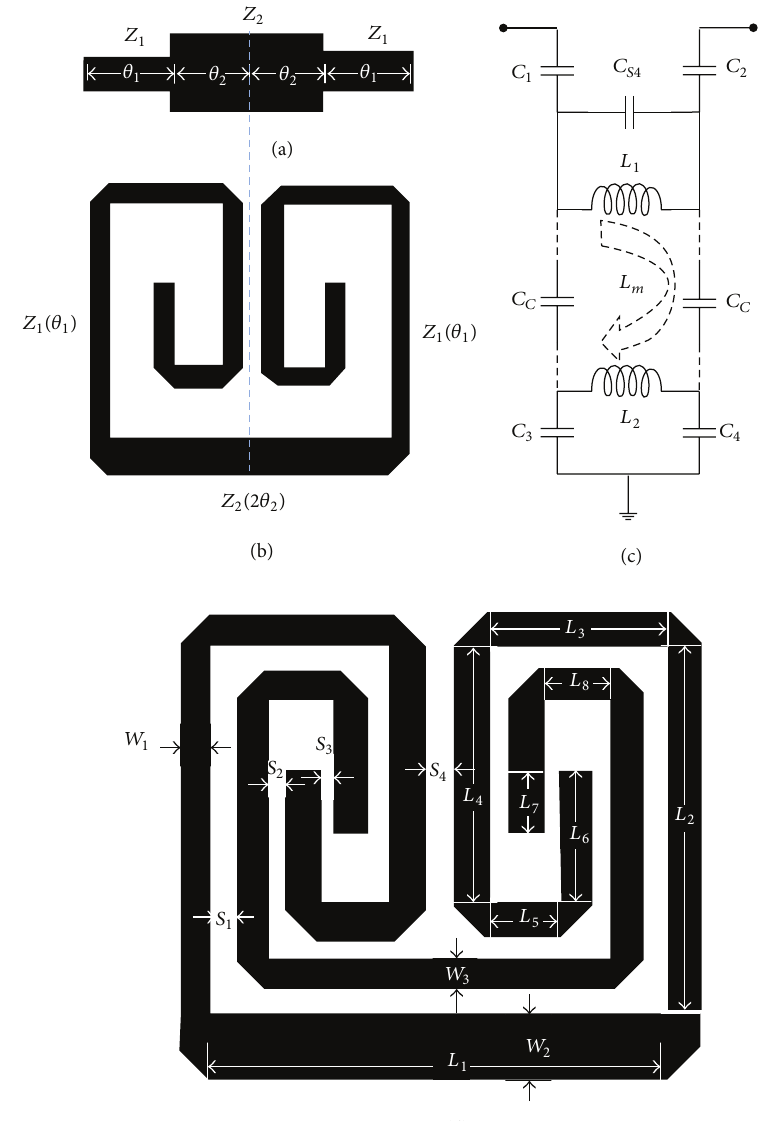
Figure 1: Configuration of (a) symmetric two-section SIR, (b) symmetric two-section meandered-line SIR, (c) equivalent circuit of the proposed meandered-line SIR with a meandered-line stub-load, and (d) meandered-line SIR with a meandered-line stub-load. and fabricated on a Gallium Arsenide (GaAs) substrate. The measured return and insertion losses of the filter are 39.1